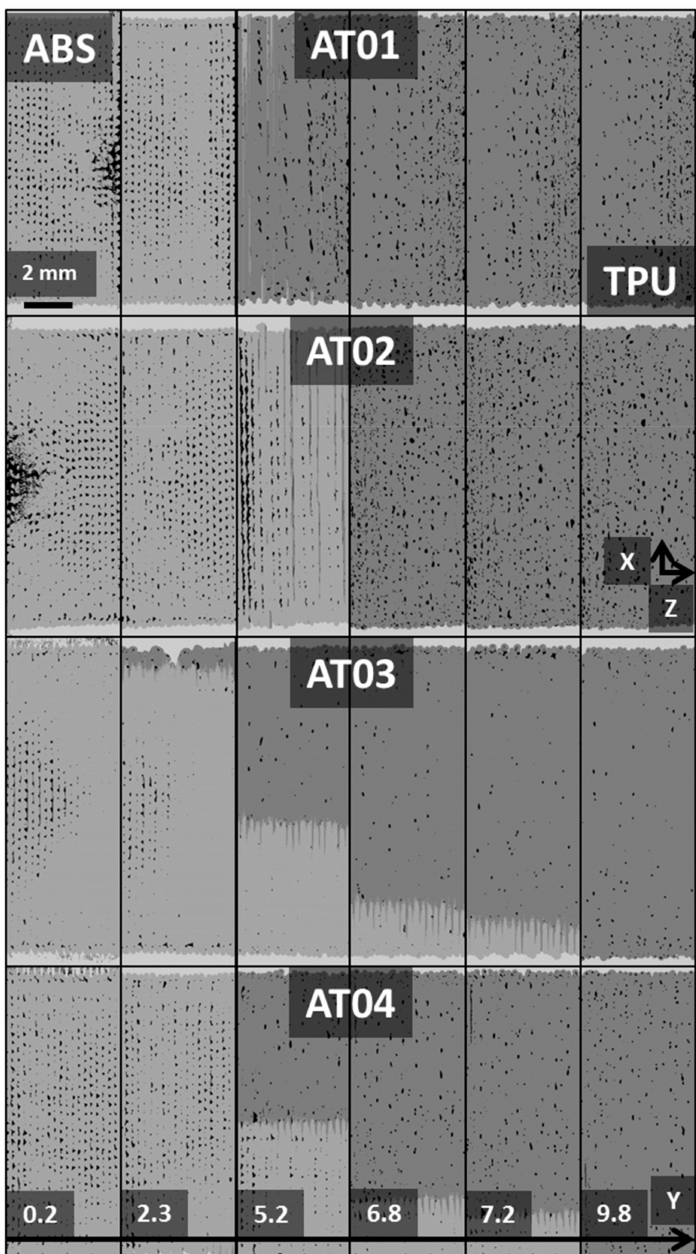
Figure 9. X–Z cross-section views (dimensions 10 mm × 4 mm) at different length positions (Y) for all printed ABS/TPU samples. (The phase contrast was achieved after image